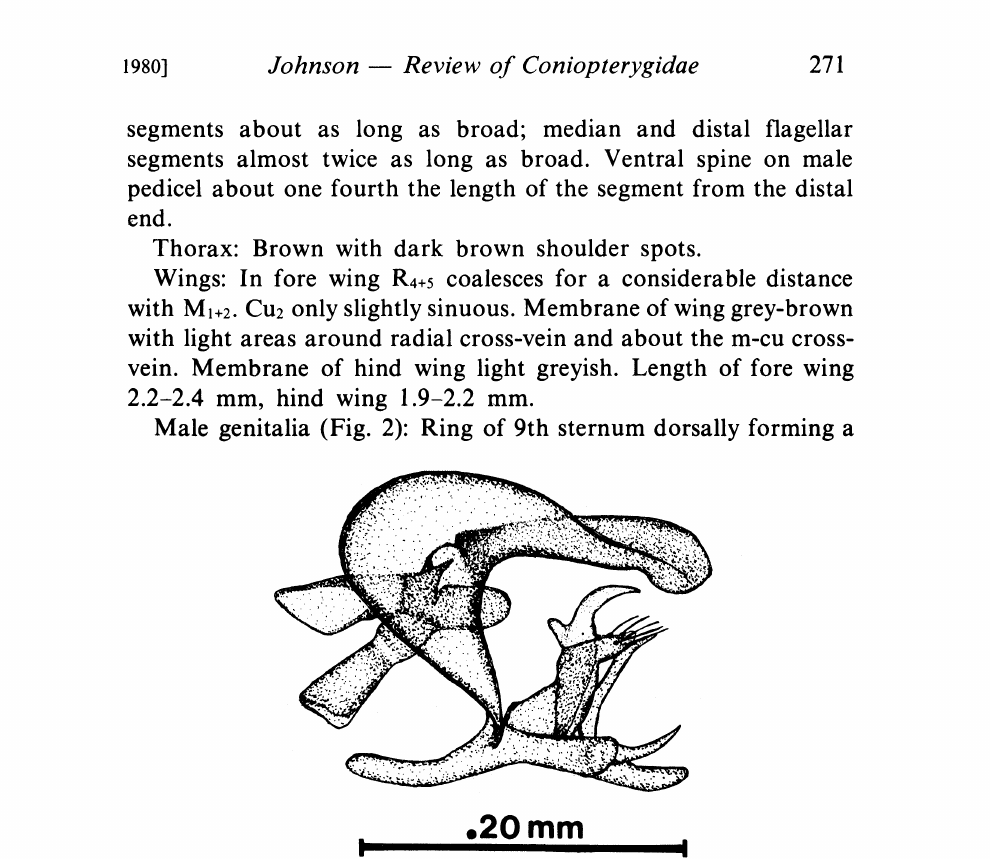
Figure 2. Aleuropteryx arceuthobii. Male genitalia, lateral